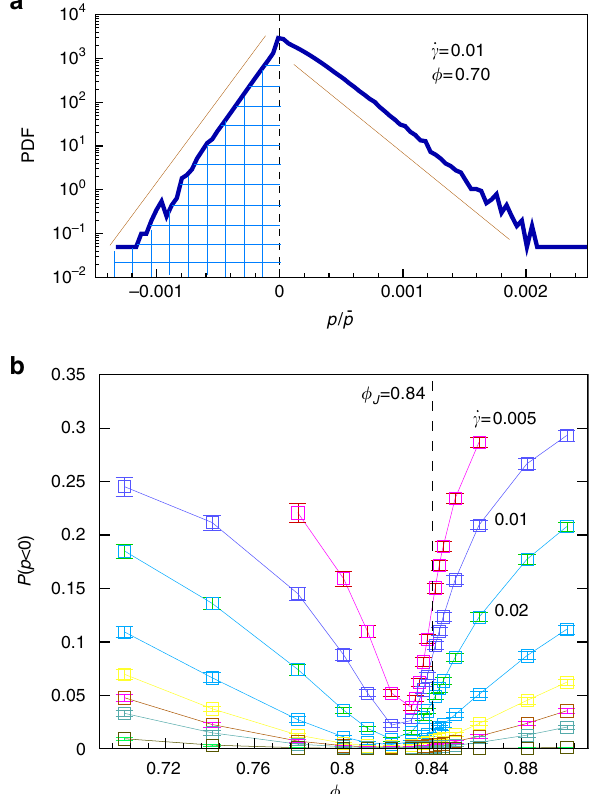
Fig. 1 Probability of rare fl uctuations. a A typical PDF of the rescaled power p = p for ϕ = 0.7, _ γ ¼ 0 : 01, and L = 30. The solid straight lines show the exponential decay of the PDF for large and small arguments. The area of the shaded region gives the probability, P ( p < 0), that the local power takes a negative value, i.e., to encounter a negative power injection. b The probability to observe a negative power injection P ( p < 0) as a function of packing fraction ϕ for different shear rates _ γ ¼ 0 : 005 ; 0 : 01 ; 0 : 02 ; 0 : 04 ; 0 : 06 ; 0 : 08 ; 0 : 1 and 0.2 from top to bottom, respectively, and system size L = 30. The vertical dashed line marks the critical packing fraction, ϕ J , where the jamming transition occurs in the static limit. Error bars correspond to square root of